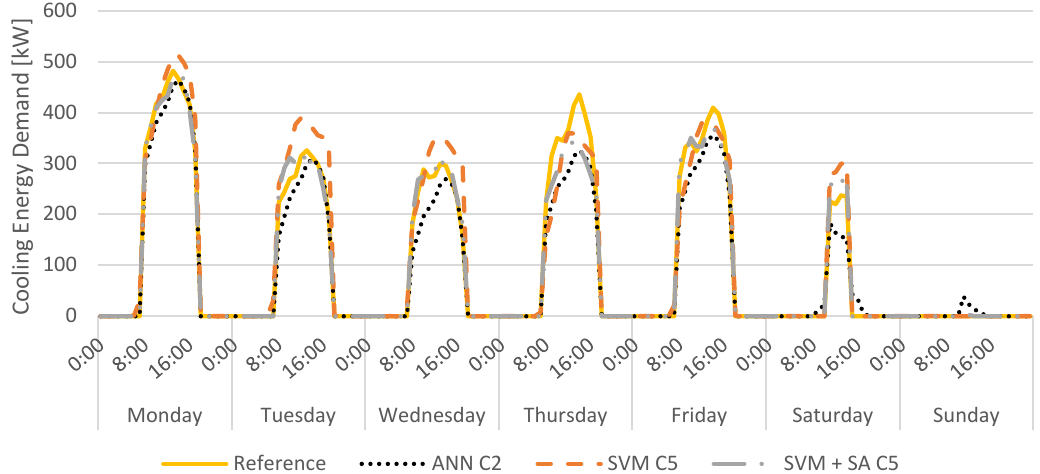
Figure 23. Cooling energy demand load profile for the best performing models, for a full week, from the test subset.